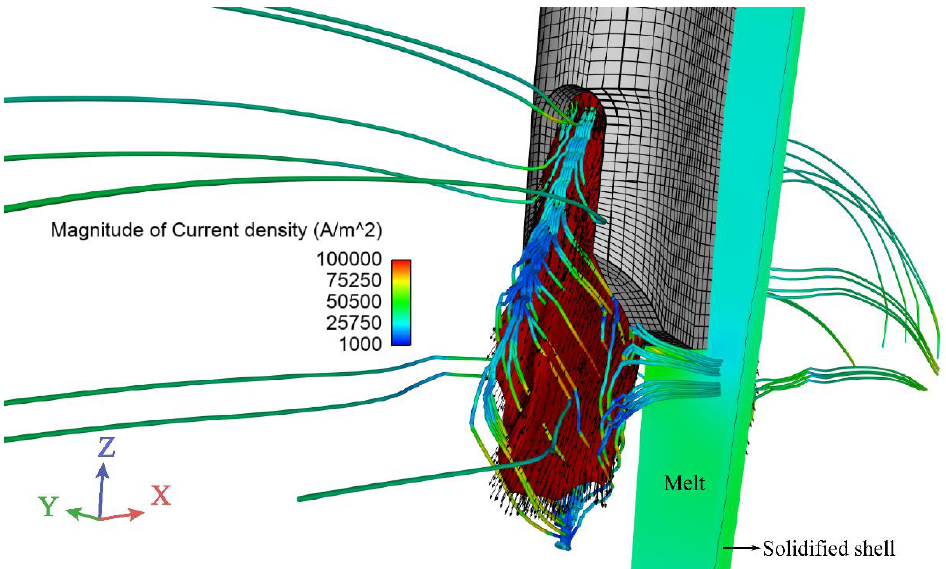
Figure 4. ( a ) Contour plot of the exterior magnetic field arising from the EMBr in one quarter of the mold. The x-, y-, and z-axis were along the direction of the width, thickness, and height of the mold, respectively. The origin had the same height as the pole center of the EMBr magnet. ( b ) Field strength in the three lines. The negative direction of the z-axis was the same as the casting direction.